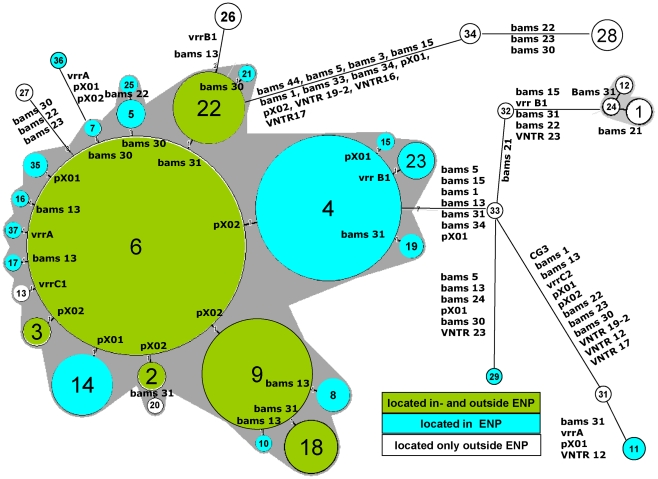
Minimum spanning tree of 377 Namibian isolates typed by MLVA.Clustering of MLVA profiles was done using a categorical coefficient. The MLVA-GTs are displayed as circles with the appropriate GT number. The size of each circle symbolizes the number of isolates of this particular GT. GTs differing in only one marker are combined in a complex seen as a gray halo if at least 3 GTs fulfill this criterion. The marker(s) on which the mutation is located is shown. Distances between circles do not reflect the correct phylogenetic distances. The vaccine isolates are not included. The relations within this tree remain the same if an outgroup like the B-cluster (as used in Figure S1) is included (not shown).